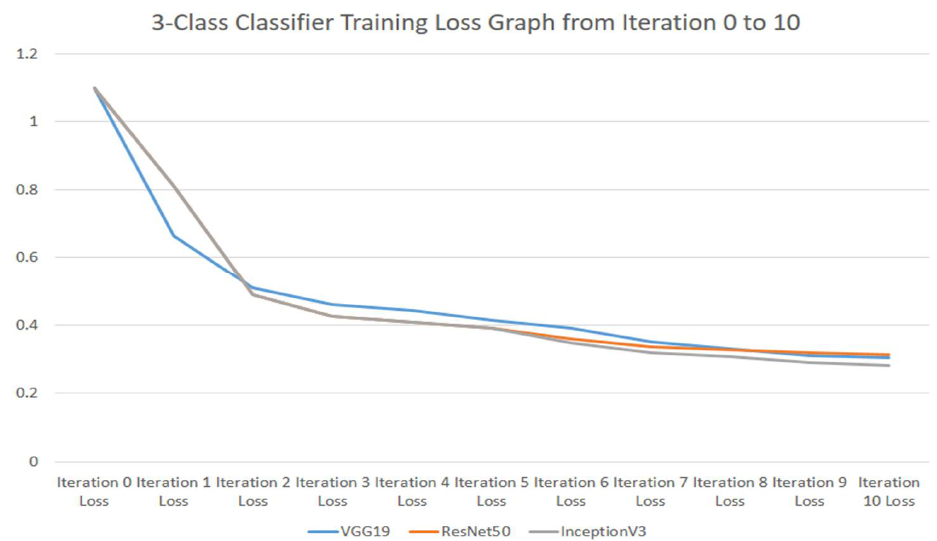
Figure 6. Three-class classifier training-loss graph from iteration 0 to 10 for VGG19, ResNet50, and InceptionV3 models.